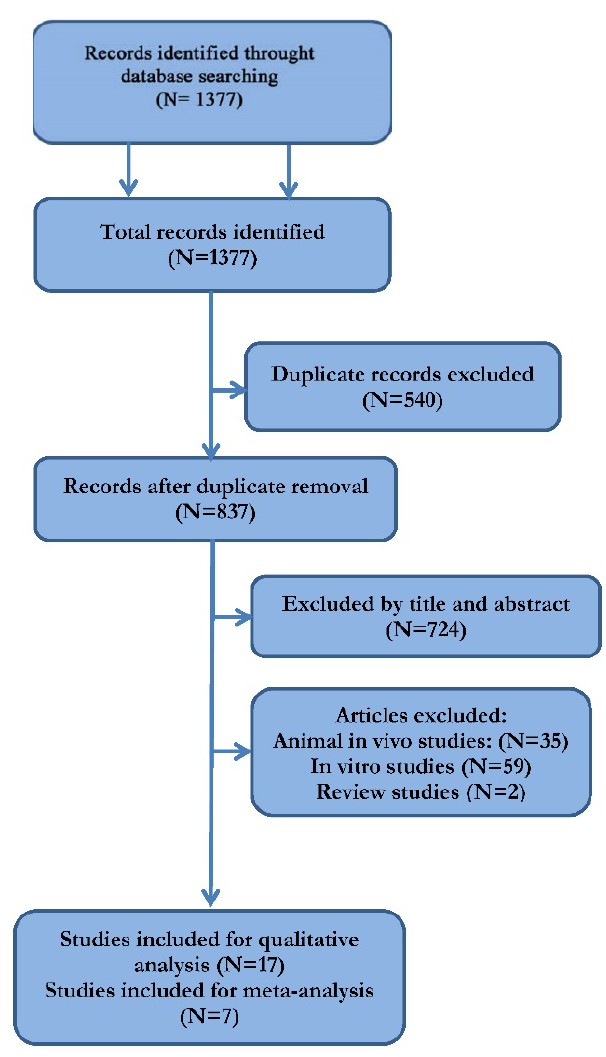
Table 3. Preferred Reporting Items for Systematic Reviews and Meta-Analysis (PRISMA) flowchart for the searching and identification of included